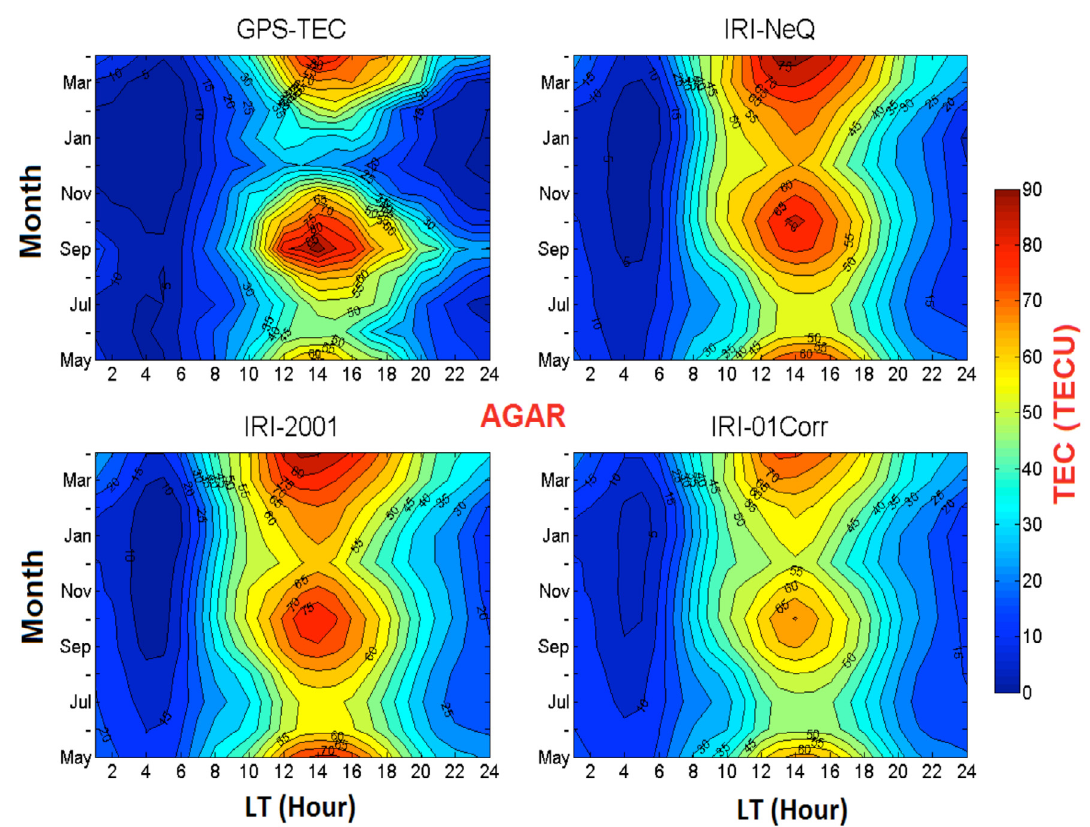
Figure 4. Contour diagram of monthly mean variation of GPS-TEC, IRI 2012 model TEC (NeQuick, IRI- 2001 and IRI-01-corr) at Agartala (AGAR) (Geomagnetic lat. 14.22°N), from May 2012 to April 2013.